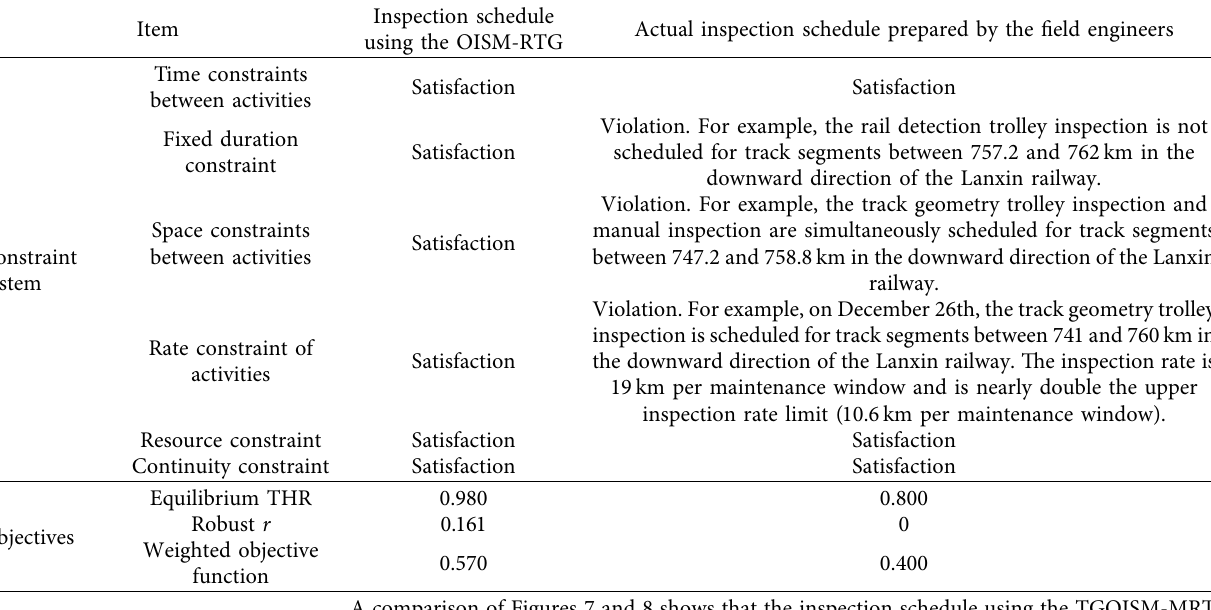
Figure 8: Track inspection schedule in the Lanxin railway using model TGOISM-MRT. Table 4: Comparison of actual and optimized track inspection